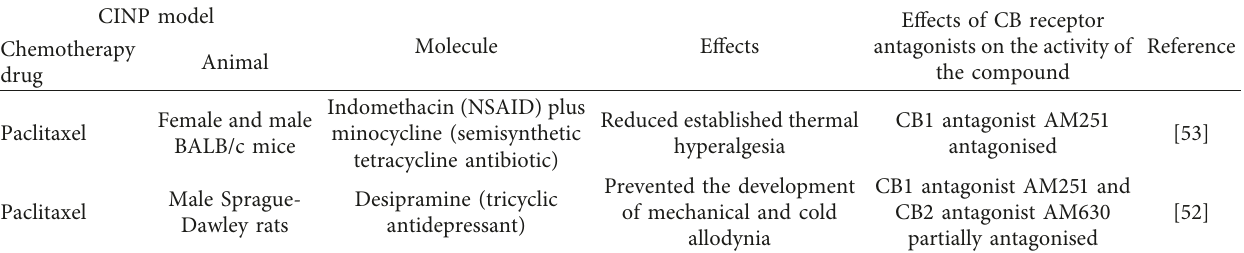
Table 5: Effects of other agents, in a CB receptor-dependent manner, in animal models of CINP. CINP model Molecule